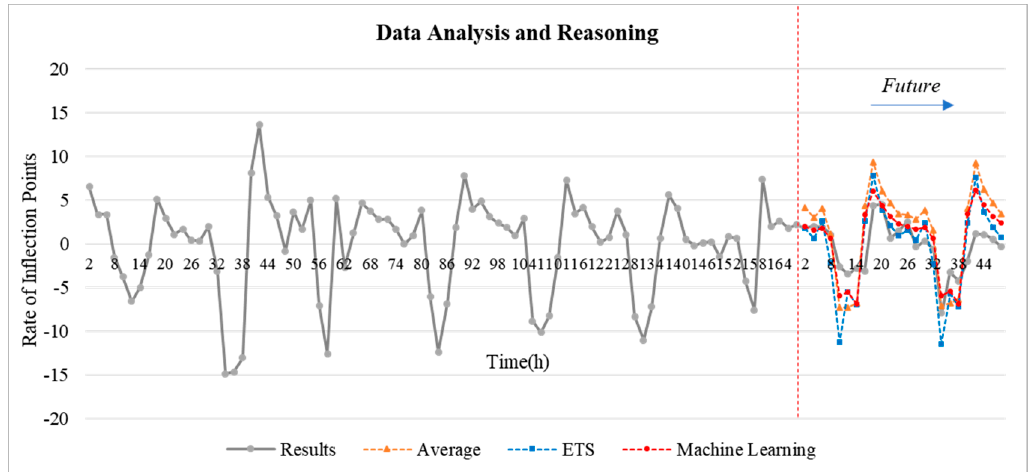
Figure 7. Data Analysis and Forecasting.